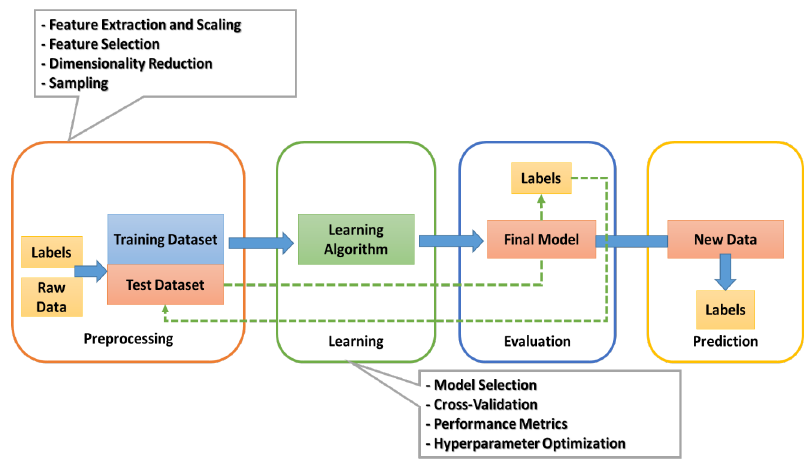
Figure 1. Typical machine-learning system [2].